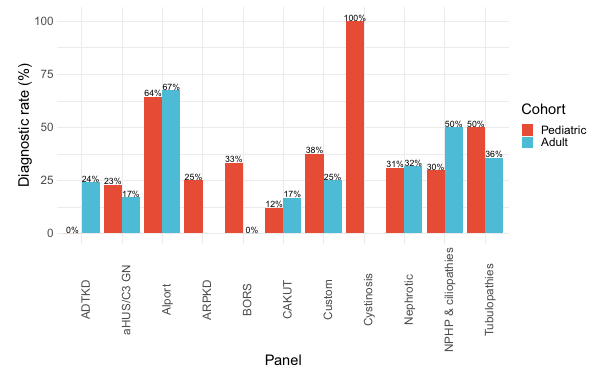
Fig. 6 Diagnostic rate of pathogenic or likely pathogenic variants, strati fi ed by panel and cohort. There were 278 families with a pediatric proband and 266 families with an adult proband. Two families had both affected pediatric and adult probands. Variant classi fi cation was based on 2015 ACMG guidelines 20 . Abbreviated panels are as follows: ADTKD autosomal dominant tubulointerstitial kidney disease, aHUS/C3 GN atypical hemolytic uremic syndrome-C3 glomerulonephritis, Alport Alport syndrome, ARPKD autosomal recessive polycystic kidney disease, BORS branchio-oto renal syndrome, CAKUT congenital anomalies of the kidney and urinary tract, Nephrotic nephrotic syndrome, NPHP & ciliopathies nephro- nophthisis & related